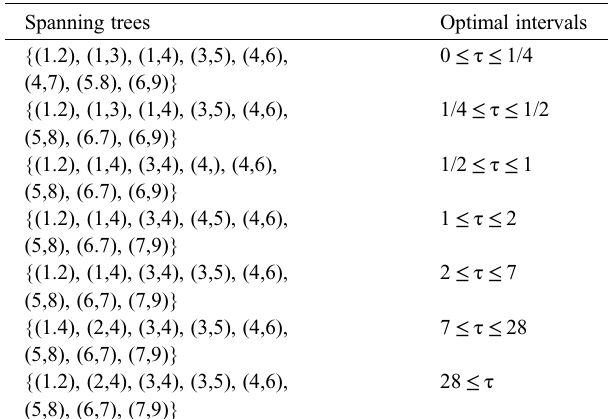
CTP optimal spanning trees for Example 4 (Vasko et al., 2002) with (3,5) edge length equal to 4 Spanning trees Optimal intervals